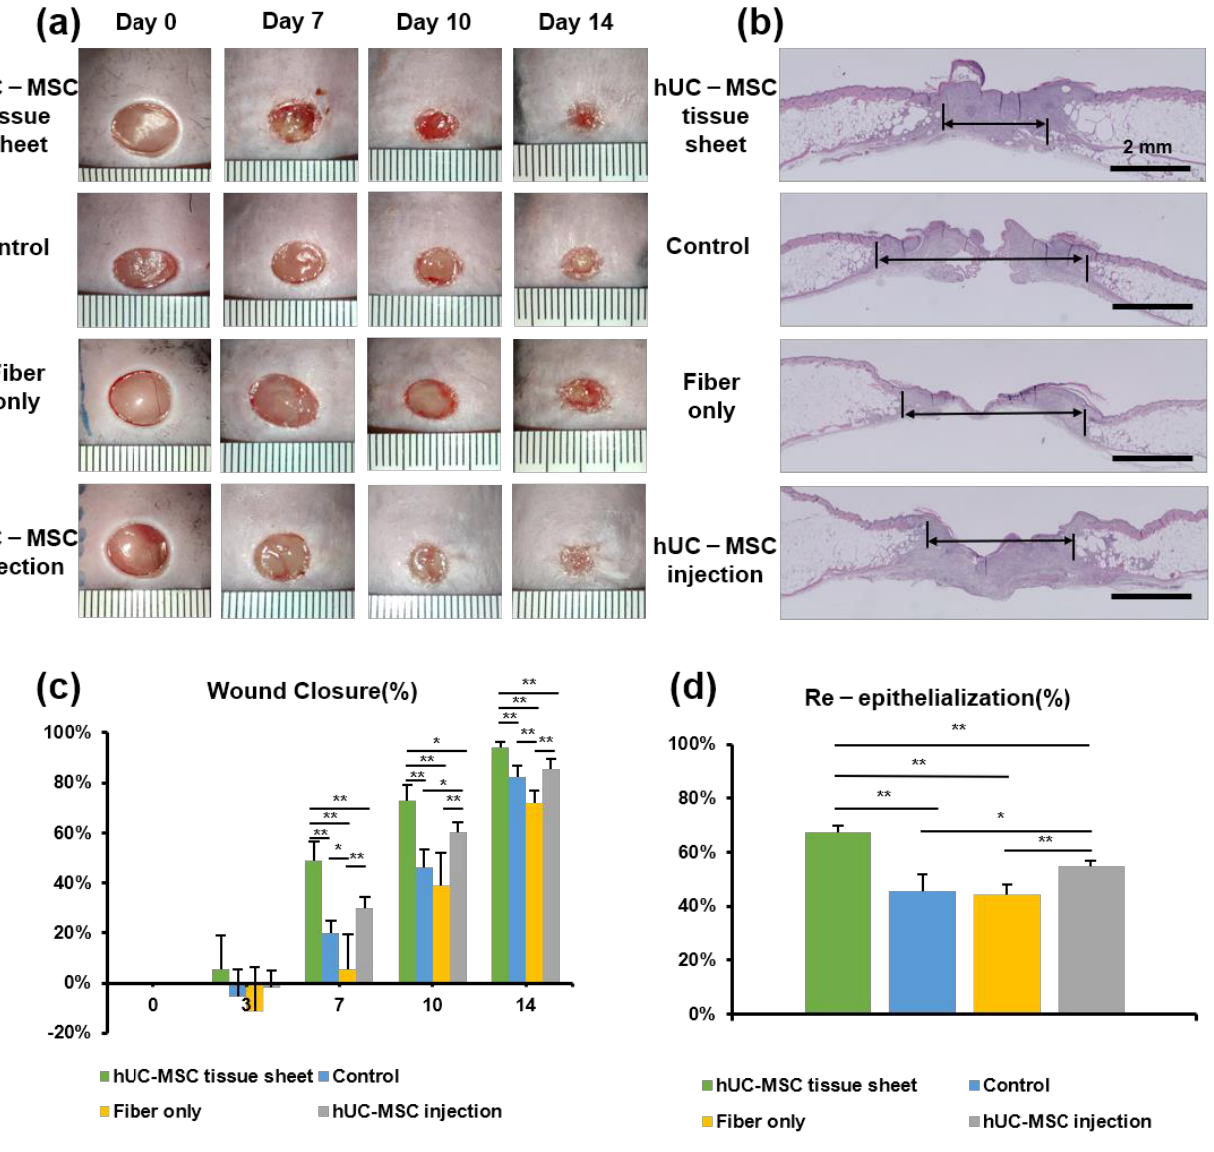
Figure 3. Human umbilical cord mesenchymal stem cell (hUC-MSC) tissue sheet accelerates diabetic wound healing. ( a ) Representative photographs of full-thickness excision wounds at 0, 7, 10, and 14 days after wounding. ( b ) Hematoxylin and eosin staining of wound sections treated with hUC-MSC tissue sheet, fiber only, and hUC-MSCs injection 14 days after wounding. The double-headed black arrows indicate the edge of the scars. Scale bar = 2 mm. ( c ) Quantitative analysis of the rate of wound closure in each group. ( d ) Quantitative analysis of the extent of re-epithelialization in ( b ). Results are presented as mean ± SD. Significance was determined using analysis of variance ANOVA. * p < 0.05, ** p < 0.01.